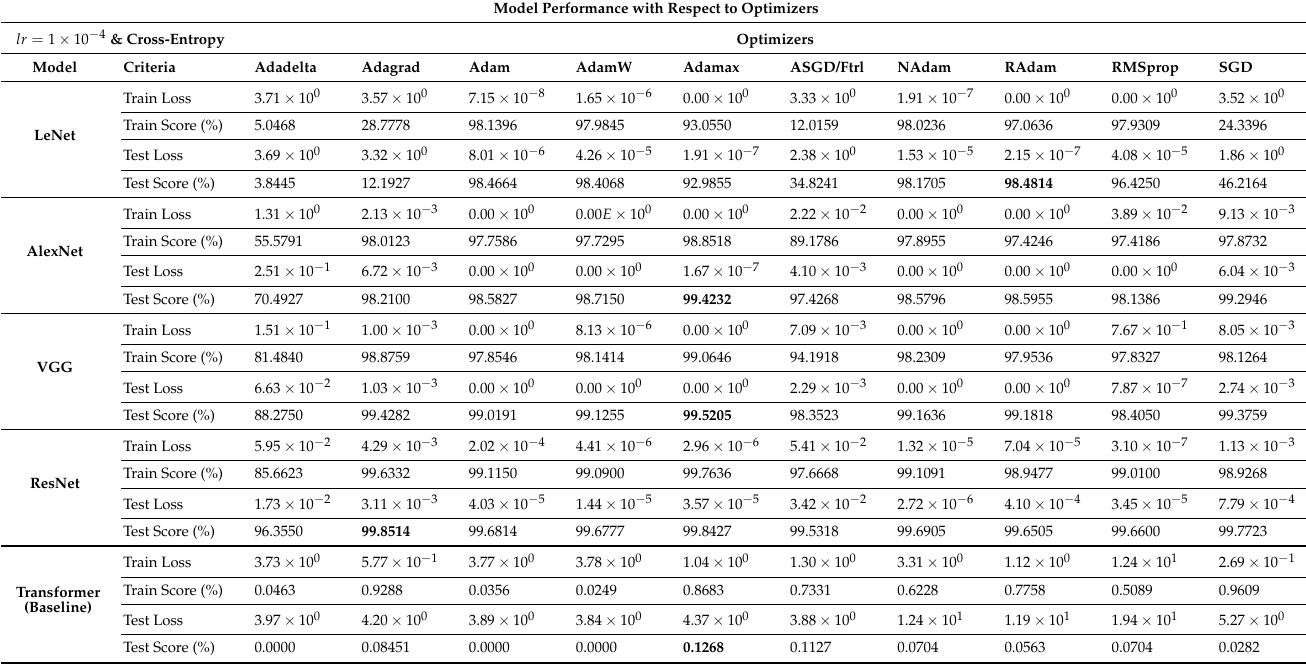
Table 5. All of the models used cross-entropy loss and kept the learning rate fixed at 1 × 10 − 4 . The performance of each model (with respect to 10 different optimizers) was tested to fine-tune the performance within 1000 epochs. All of the loss values are in scientific notation while the scores are in percentage values. Please note that for the ASGD/Ftrl column, the Ftrl optimizer [43] was solely used for the transformer as ASGD [42] is not supported by Keras [52]. ASGD was used for the rest of the optimizers in the ASGD/Ftrl column, as it is supported by PyTorch